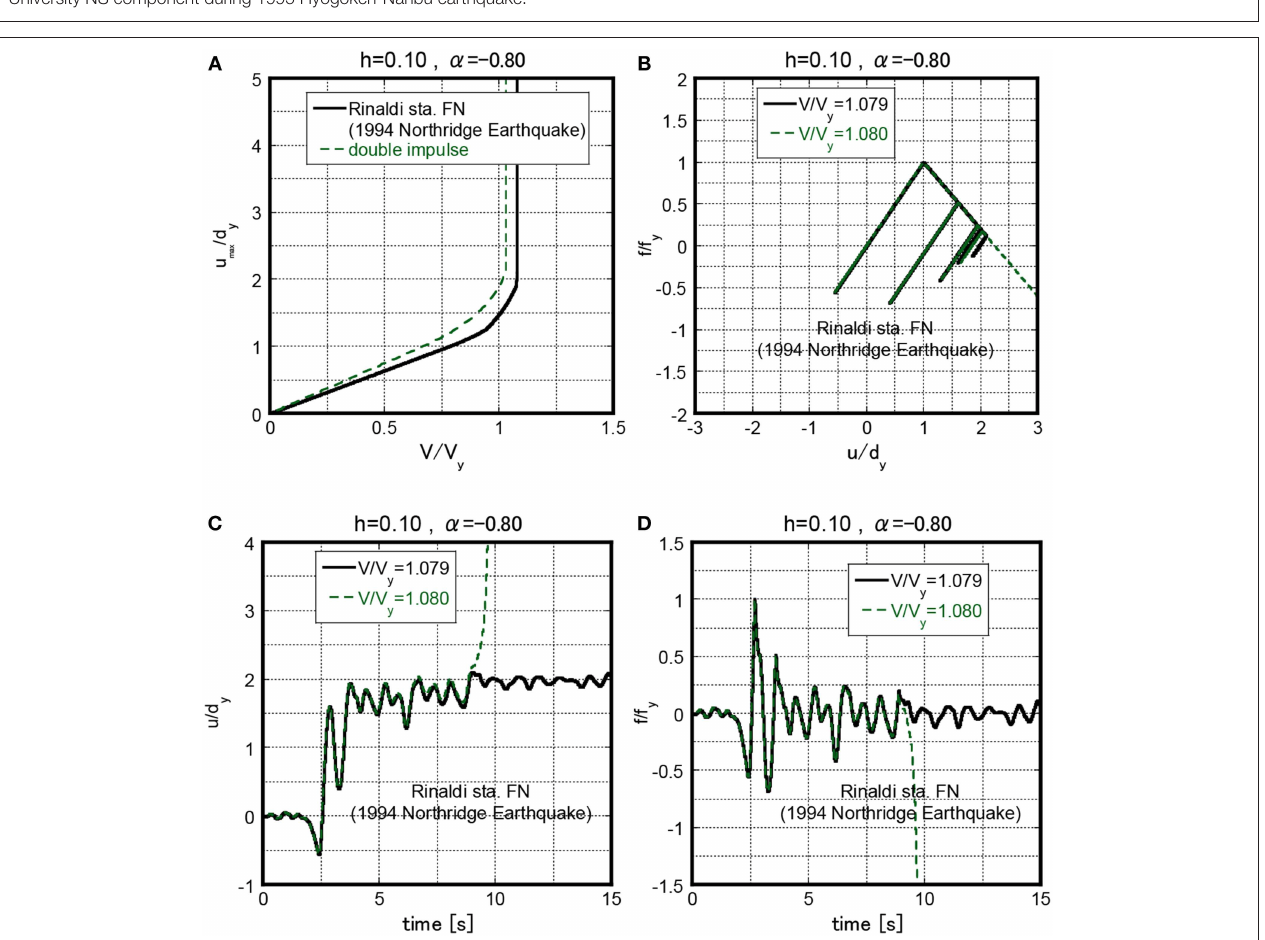
0.10, α 0.80 for stable case ( V / V y 1.079) and collapse case = = − =